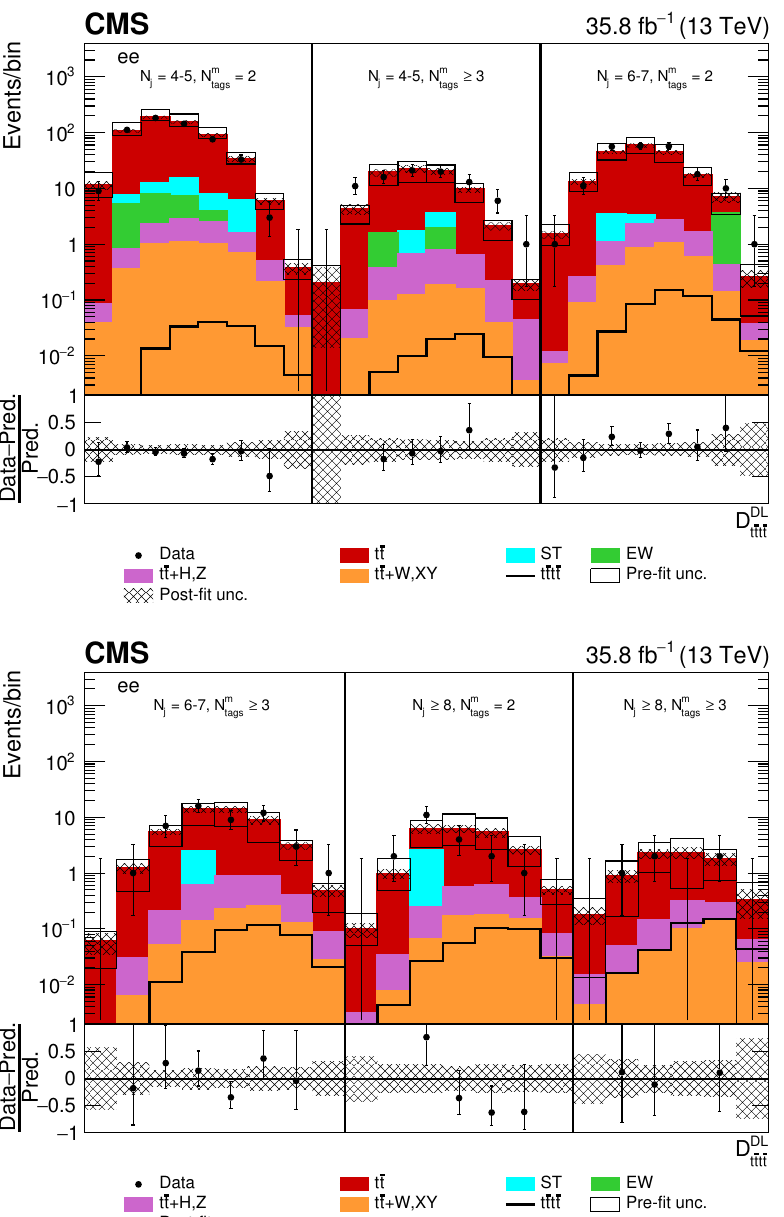
Figure 12 . Post-(cid:12)t D DL distributions in the e + e (cid:0) channel for events satisfying baseline opposite- tttt sign dilepton selection and (upper row) N = 4{5, N m = 2, (cid:21) 3, N = 6{7, N m = 2 and (lower j tags j tags row) N = 6{7, N m (cid:21) 3, N (cid:21) 8, N m = 2, (cid:21) 3. Dots represent data. Vertical error bars j tags j tags show the statistical uncertainties in data. The post-(cid:12)t background predictions are shown as shaded histograms. Open boxes demonstrate the size of the pre-(cid:12)t uncertainty in the total background and are centered around the pre-(cid:12)t expectation value of the prediction. The hatched area shows the size of the post-(cid:12)t uncertainty in the background prediction. The signal histogram template is shown as a solid line. The lower panel shows the relative di(cid:11)erence of the observed number of events over the post-(cid:12)t background